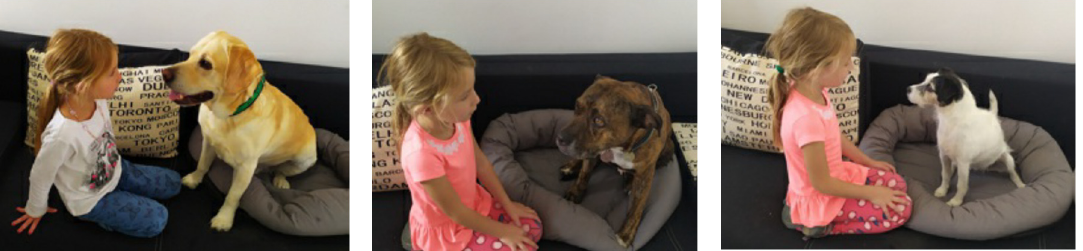
Figure 1. Tested situation called ‘Staring into the dog’s eyes’ with the Labrador ( left ), Pit Bull ( center ), and Russell ( right ).